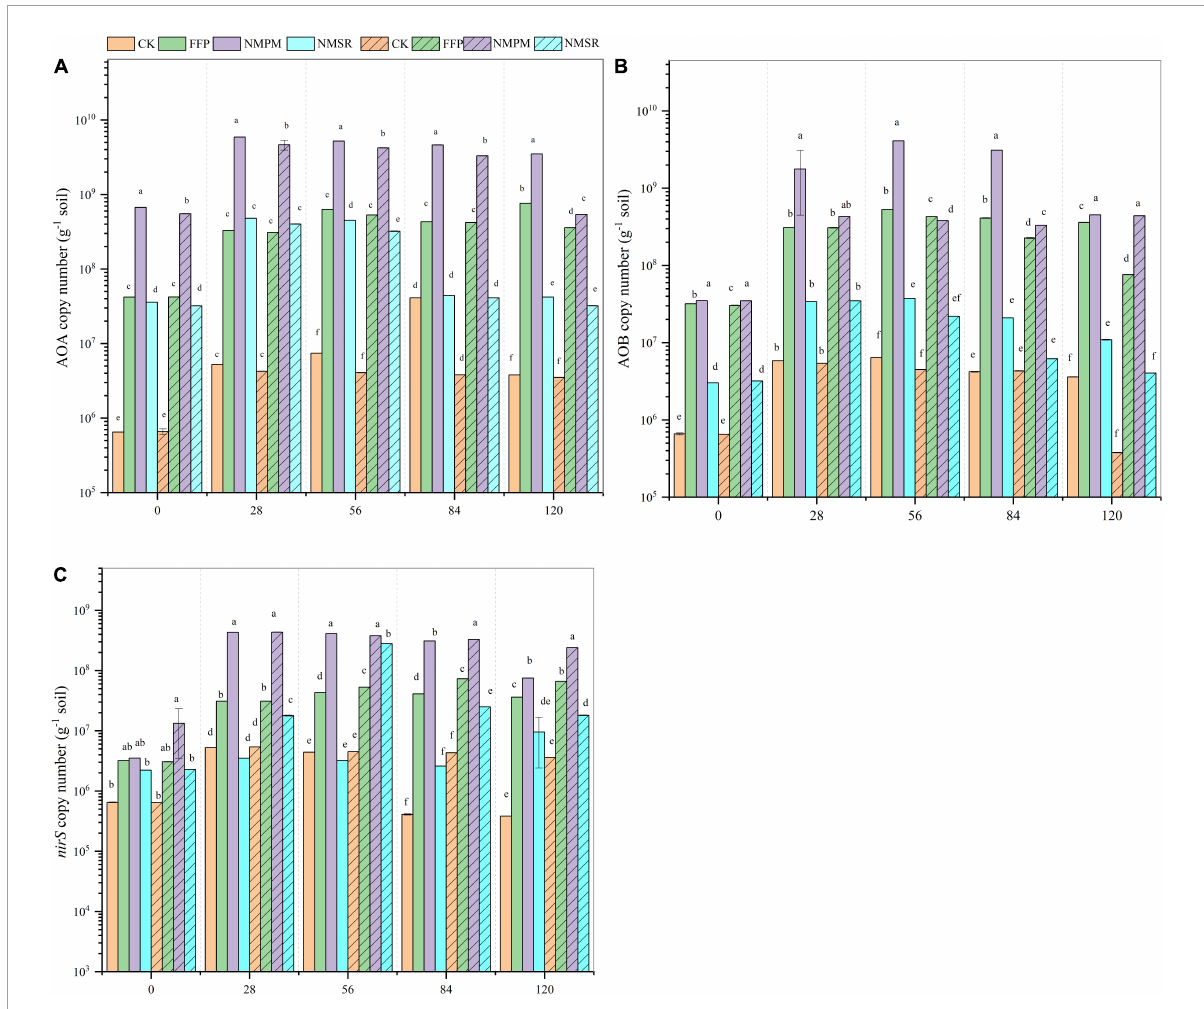
FIGURE5 Abundance of (A) AOA amoA , (B) AOB amoA , and (C) nirS functional gene (copy numbers g dry soil − 1 ) after 0, 28, 56, 84, and 120 days after transplantation during alternate wetting and drying (AWD) and permanent flooding (PF) events. Alternate wetting and drying is for alternating drying and flooding, while PF stands for permanent flooding. The panel without pattern shows AWD, while with pattern shows PF. The standard error ( n = 3 ) is shown by the arrow bar above the